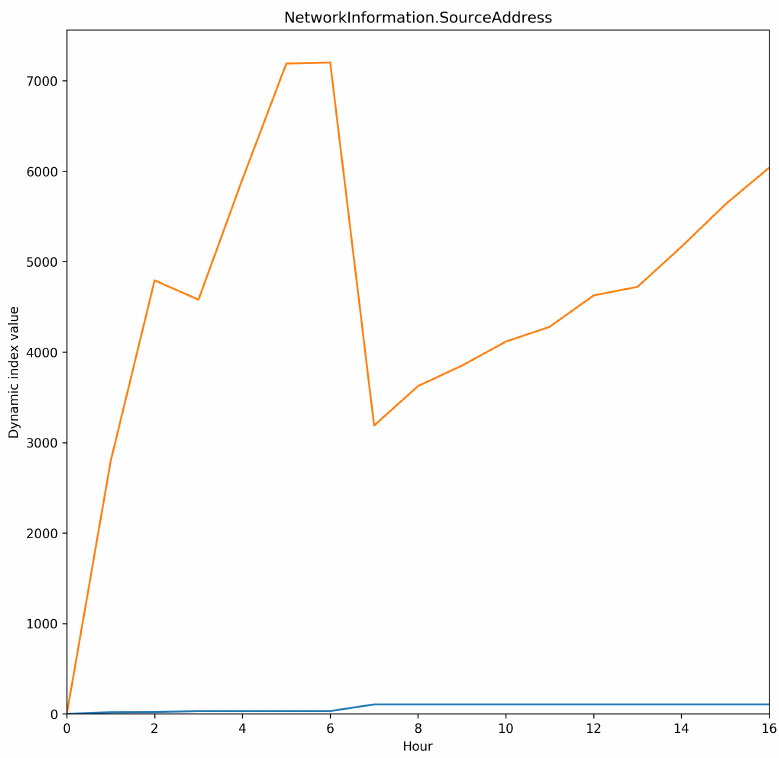
Figure 5. Dynamic indexes for the NetworkInformation.SourceAddress event